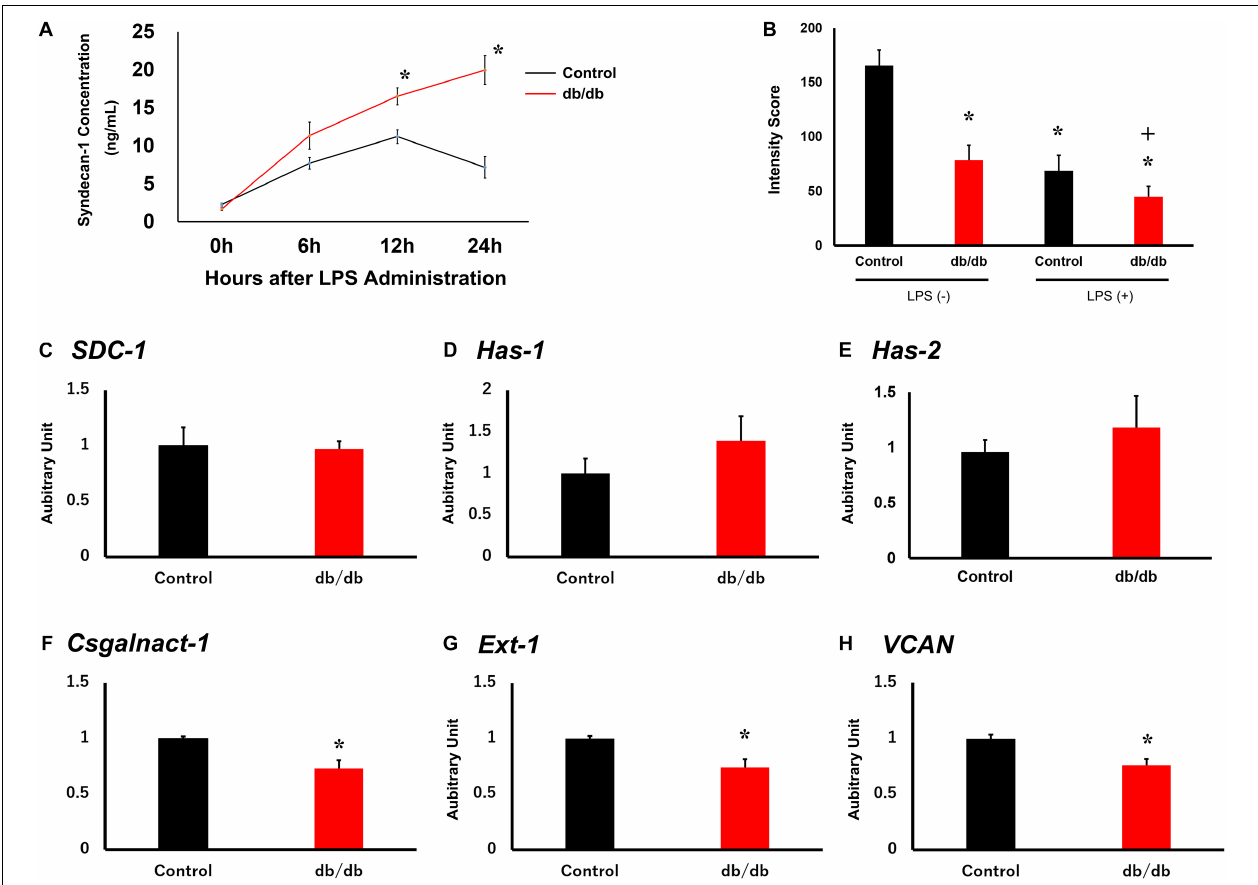
FIGURE 4 | Pulmonary endothelial glycocalyx is injured in db/db mice. (A) Serum syndecan-1 was measured in mice using an enzyme-linked immunosorbent assay. (B) Tomato lectin intensity of control and db/db mouse lungs with and without LPS administration. *, P < 0.05 vs. non-LPS-injected control mice; +, P < 0.05 vs. LPS-injected control mice. (C–H) qRT-PCR for (C) SDC1 , (D) Has1 , (E) Has2 , (F) Csgalnact1 , (G) Ext1 , and (H) Vcan in control and db/db mice under normal conditions. *, P < 0.05.